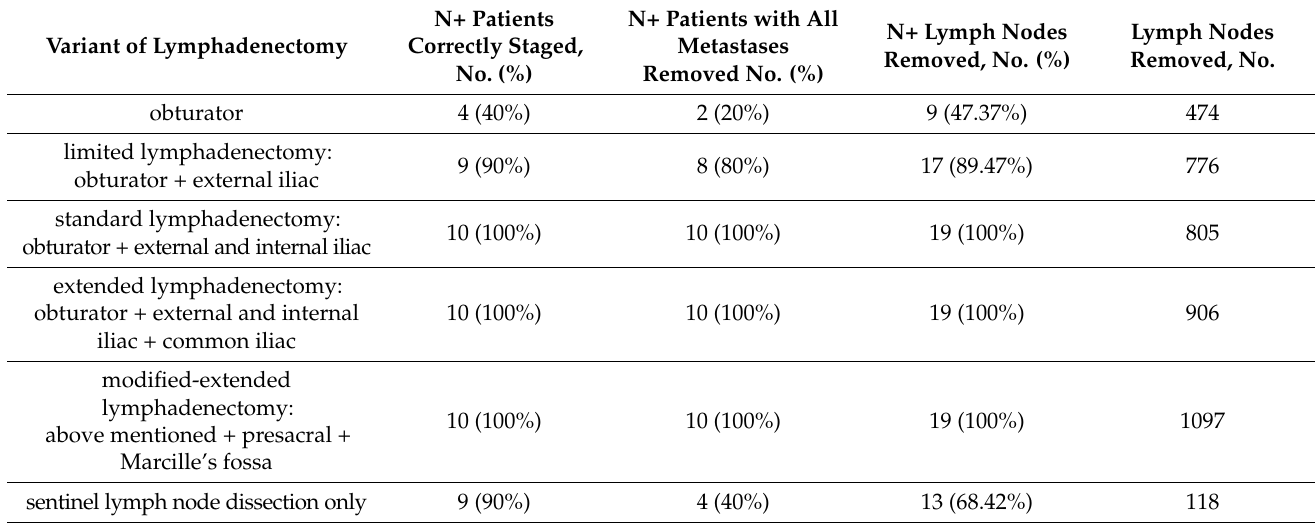
Table 3. Assessment of the correct pN staging depending on the variant of the LND template.